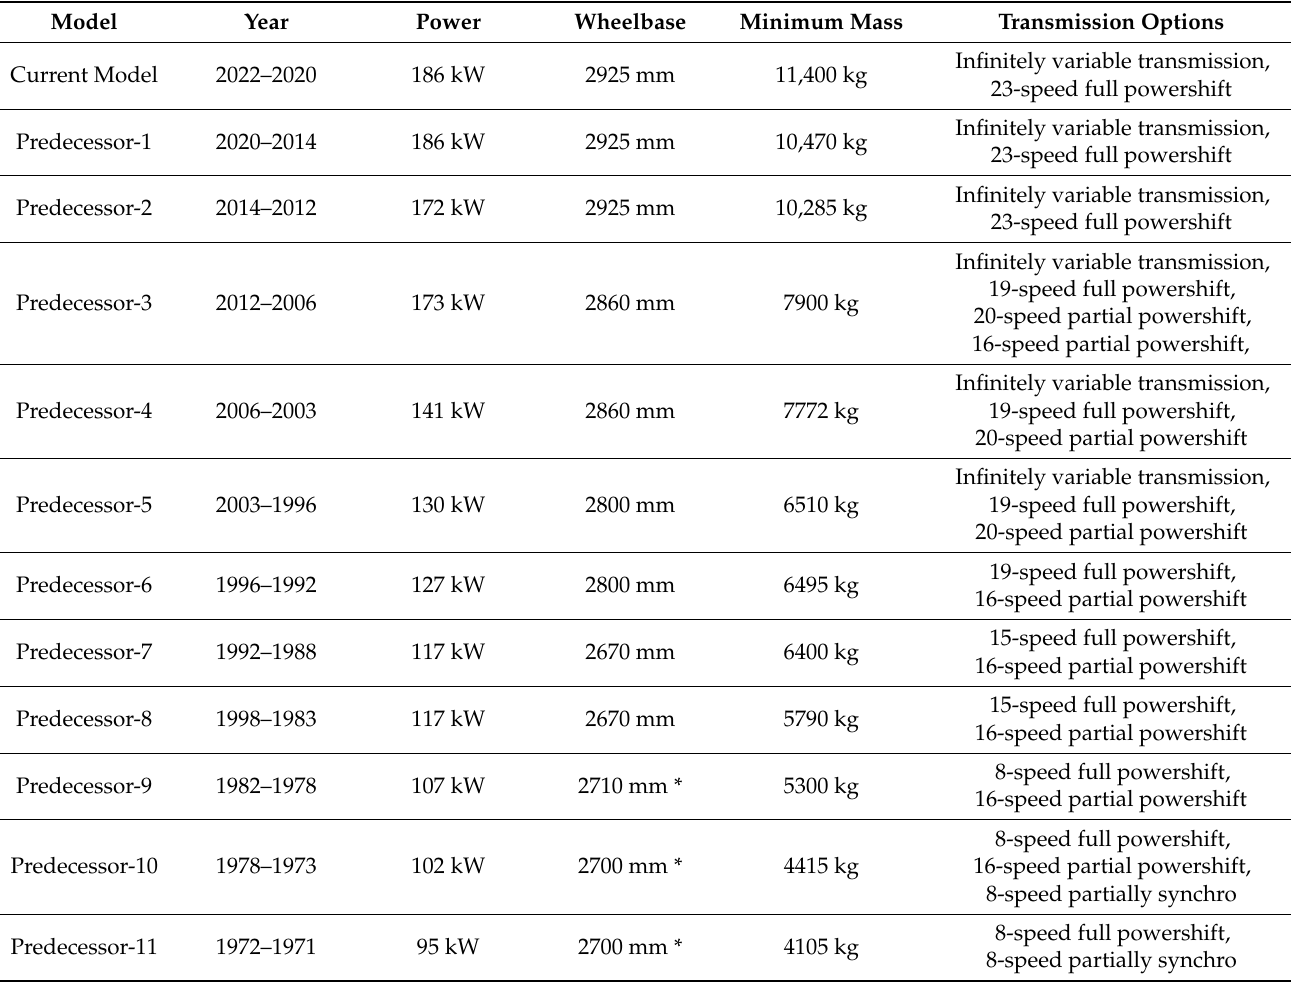
Table 4. Model evolution